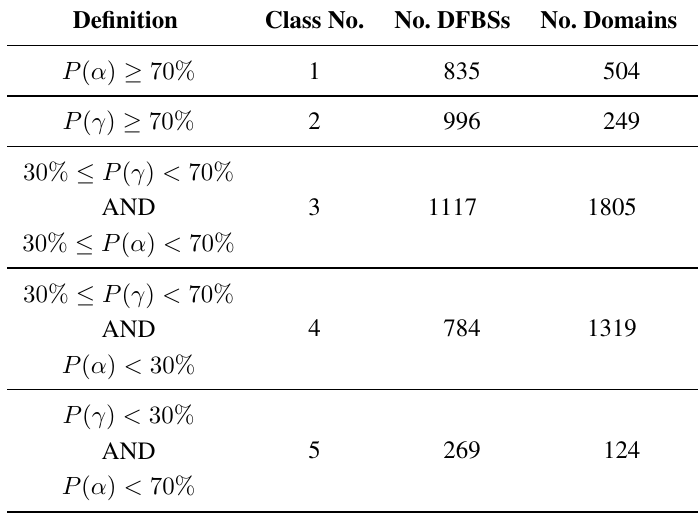
Table 1. SSE class definitions and distribution of DFBSs according to the selected ternary diagram contour